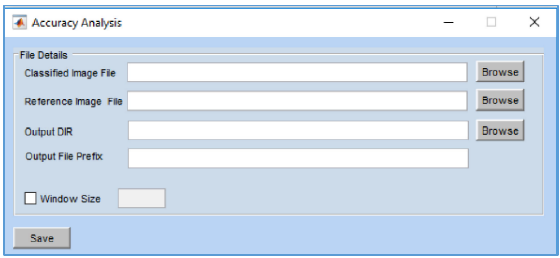
Figure 15. Interface for the accuracy assessment of the classification results with respect to reference